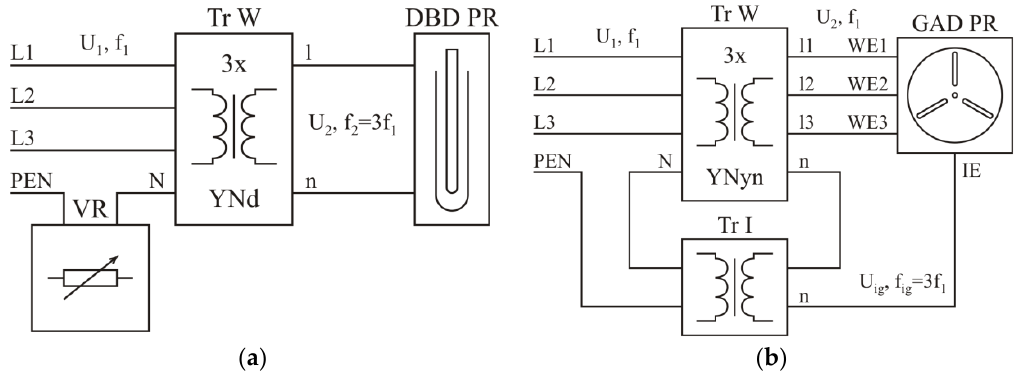
Figure 1. Integrated power supply system (IPSS) for dielectric barrier discharge (DBD) plasma reactor (PR) ( a ) and for gliding arc discharge (GAD) PR ( b ), where: Tr W — power transformer, VR — voltage regulation, Tr I — ignition transformer, WE — working electrodes, IE — ignition electrode, YNd-3-phase transformer with star-delta connection with neutral wire (N) on the primary side, YNyn-3-phase transformer with star-star connection with neutral wires on the both transformer sides [43,48 – 51].